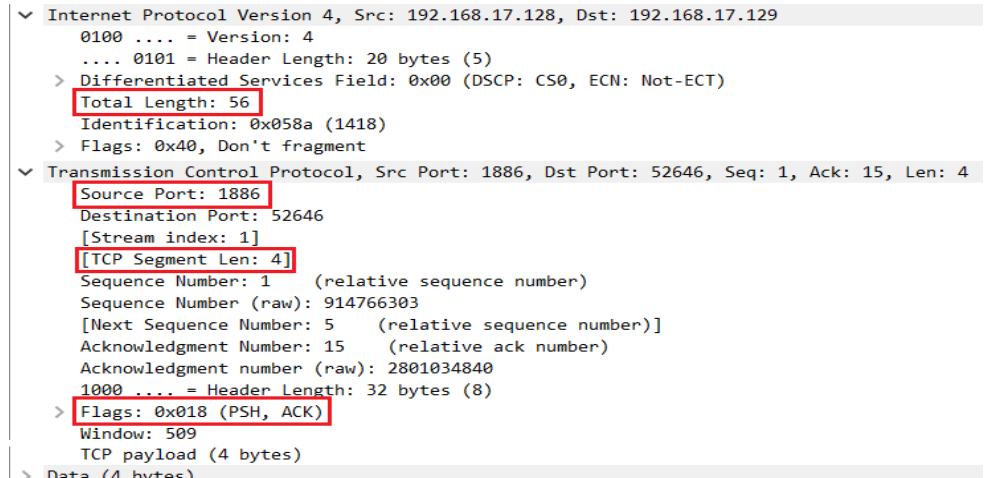
Figure 6. MQTT acknowledgement packet fields (highlighted in red-lined rectangle) used to identify MQTT protocol in signature-based